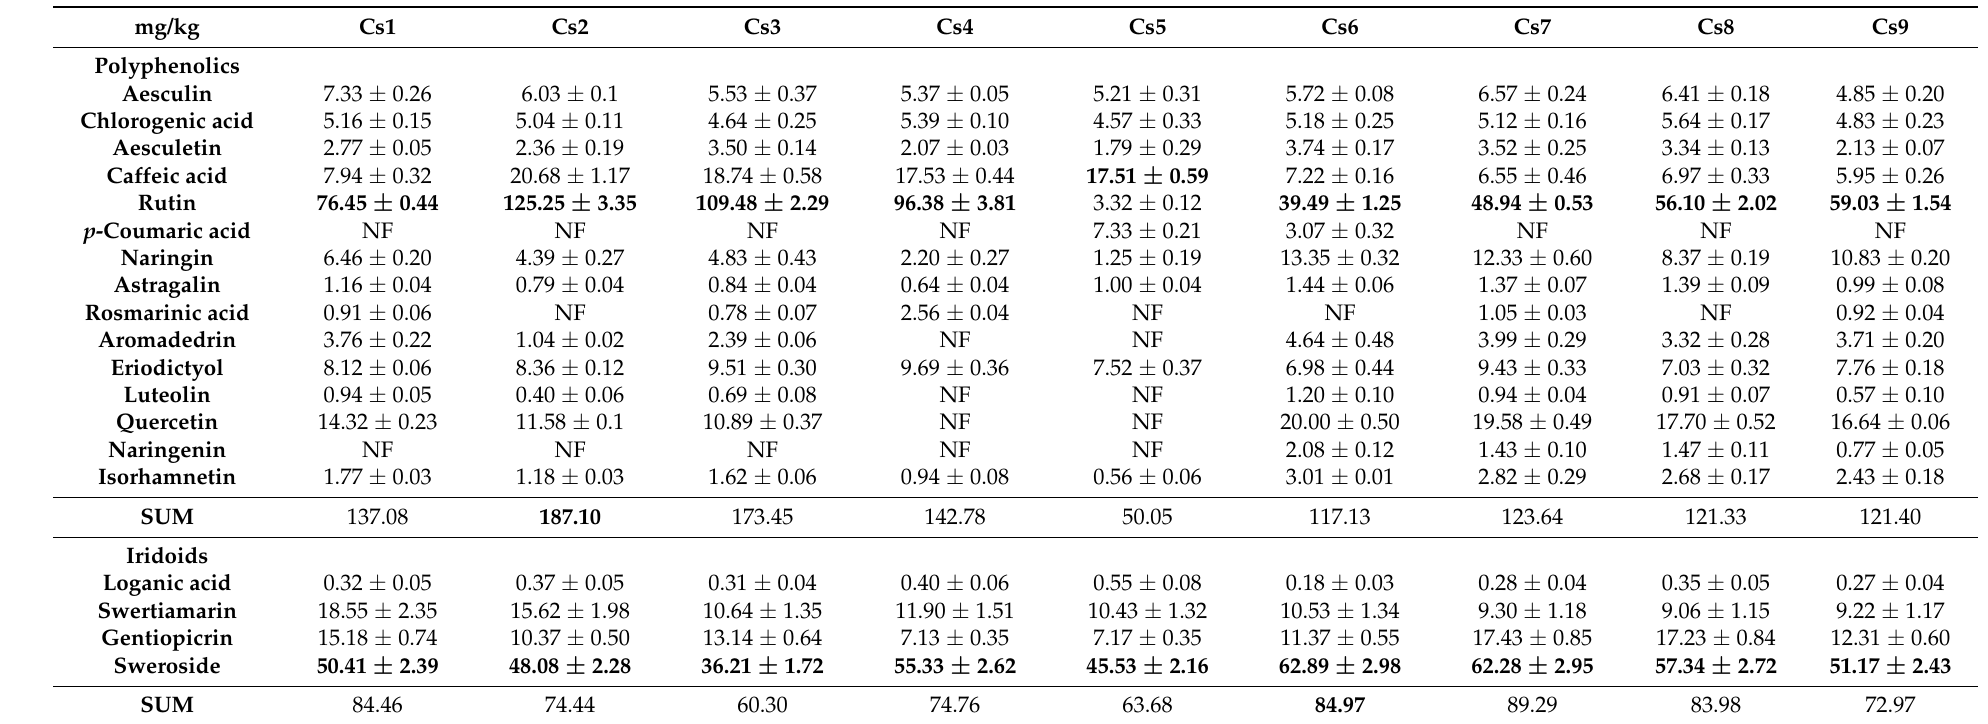
Table 2. Polyphenolic and iridoid constituents detected in C. spicatum